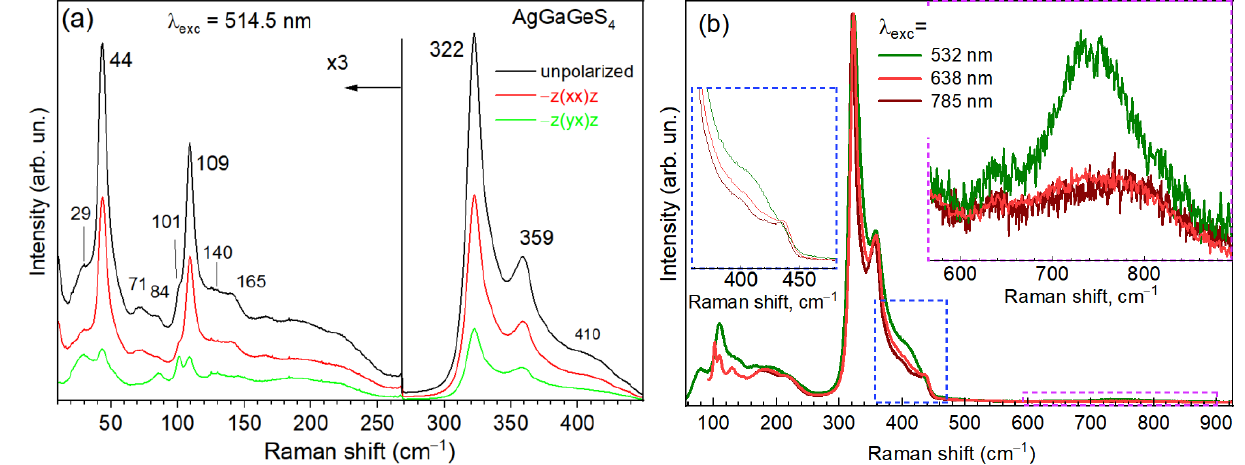
Figure 3. ( a ) Polarization-dependent Raman spectra of AgGaGeS 4 obtained at T = 300 K and λ exc = 514.5 nm. ( b ) The effect of λ exc on the first- and second-order (in the inset on the right side) Raman spectra. Table 1. Experimental phonon frequencies of AgGaGeS 4 from this study in comparison with experi- mental results on related sulfides from other works. Note that polarized Raman measurements probe A 1 (LO) and A 2 phonons, while unpolarized IR reflectivity measurements are sensitive to A 1 , B 1 , and B 2 phonons. The most intense experimental modes are marked in